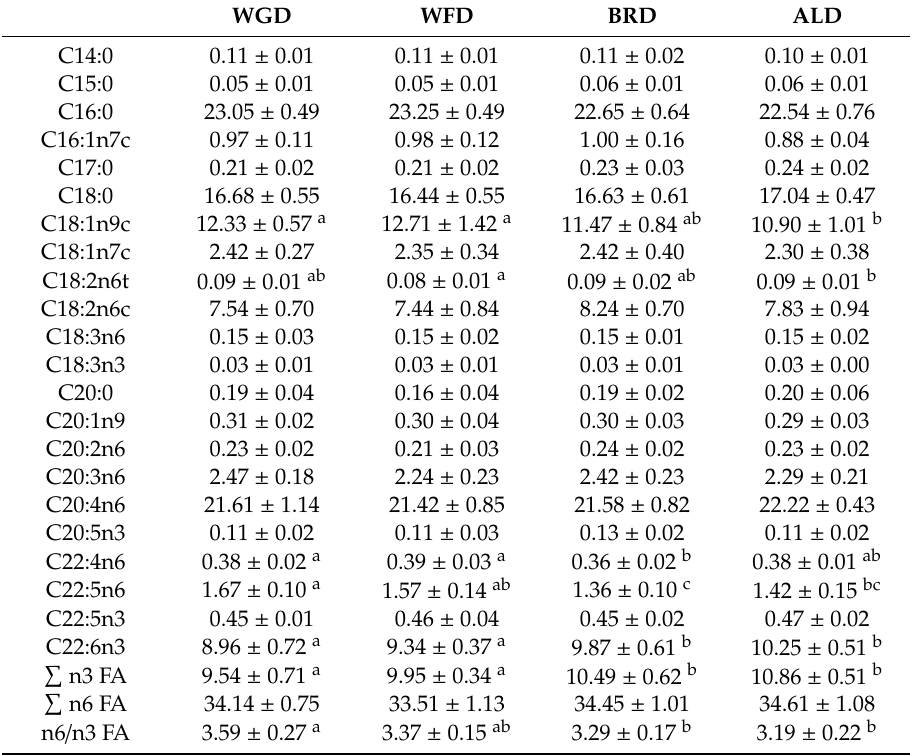
Table 3. Long-chain fatty acid composition [%] of liver phospholipids from C57BL / 6J mice fed the WGD, WFD, BRD or ALD for 12